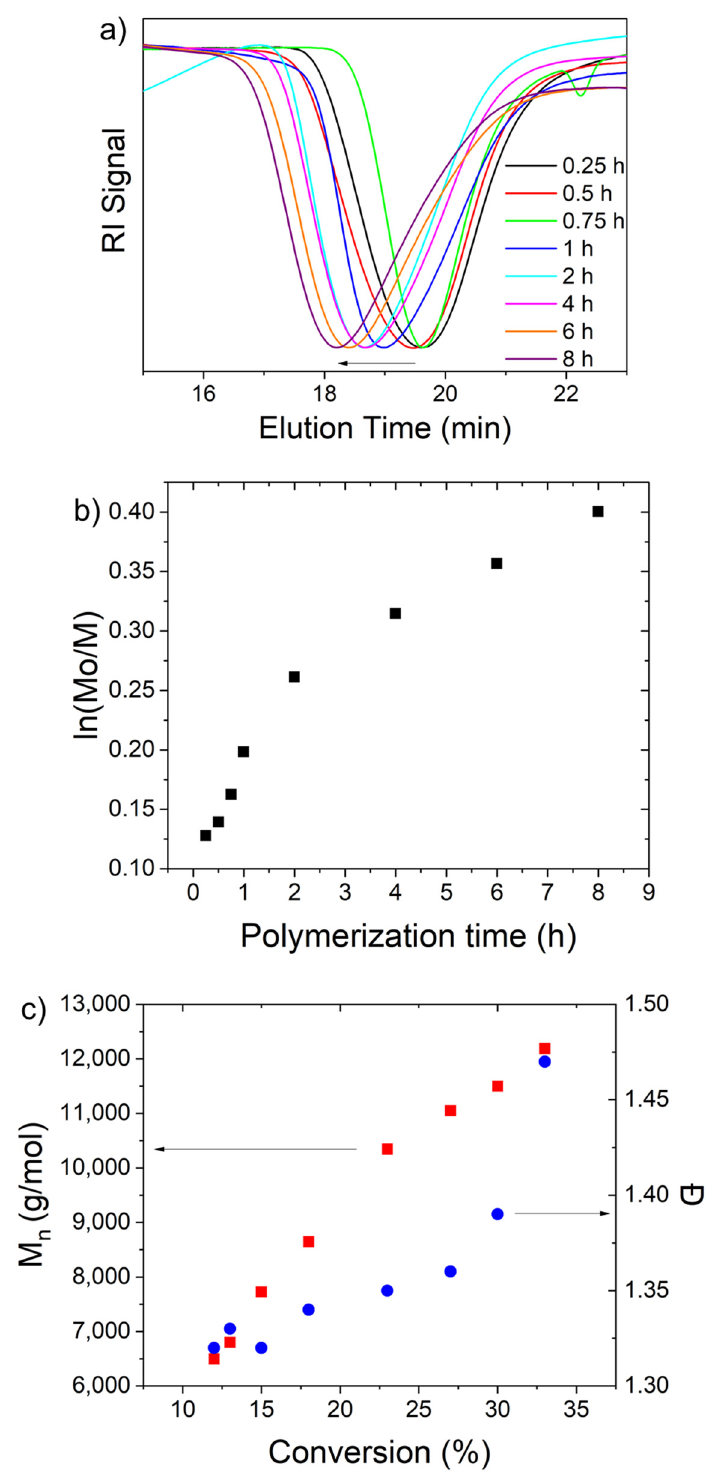
Figure 2. Plots of ( a ) GPC eluograms for the VDF/1234yf copolymerization via OMRcP, ( b ) ln([M] 0 /[M]) vs. polymerization time, and ( c ) evolution of M n and Ð vs. the comonomer conversions. Conditions [VDF] 0 /[1234yf] 0 /[P16] 0 /[Co(acac) 2 ] 0 = 80/20/2/1 at T = 60 °C.